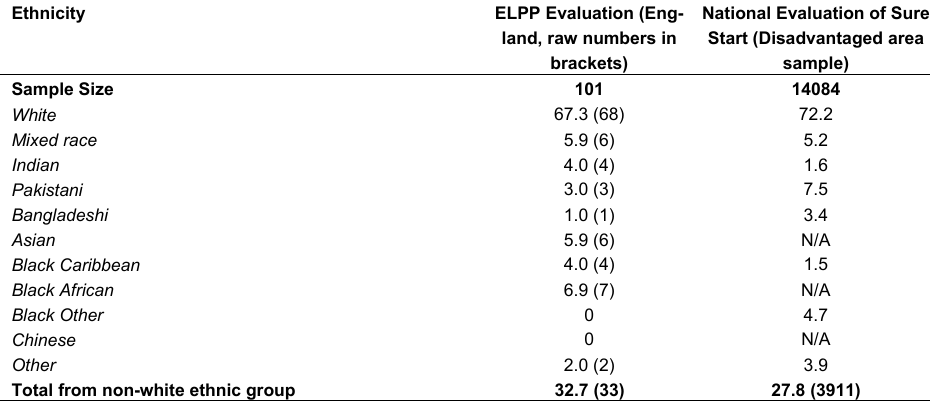
Table 2 : Comparing the ELPP parent sample to NESS: ethnicity